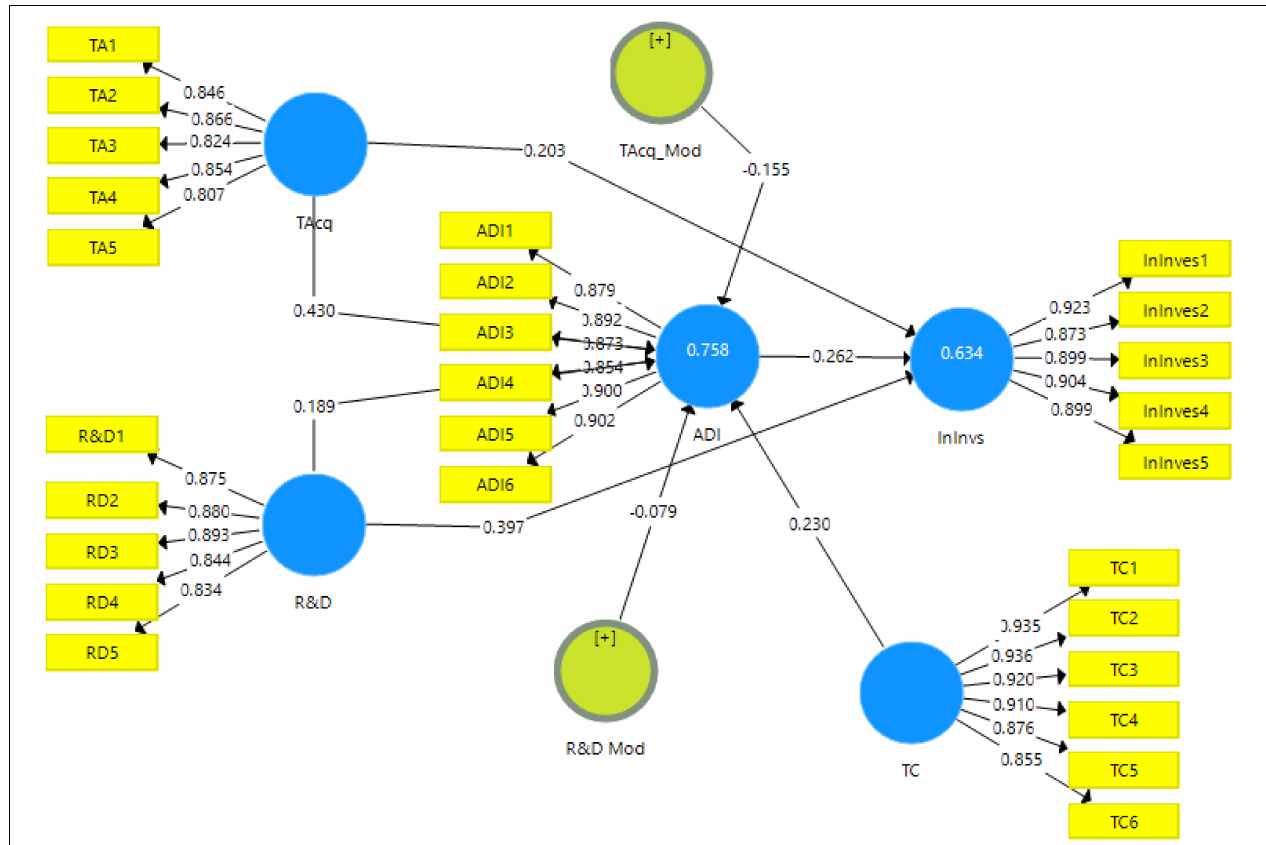
FIGURE 2 | Output of measurement model. TAcq, Technological Acquisition; R&D, Research and Development; InInvs, Innovation Investment; ADI, Attitude toward Digital Innovation; TC, Technological